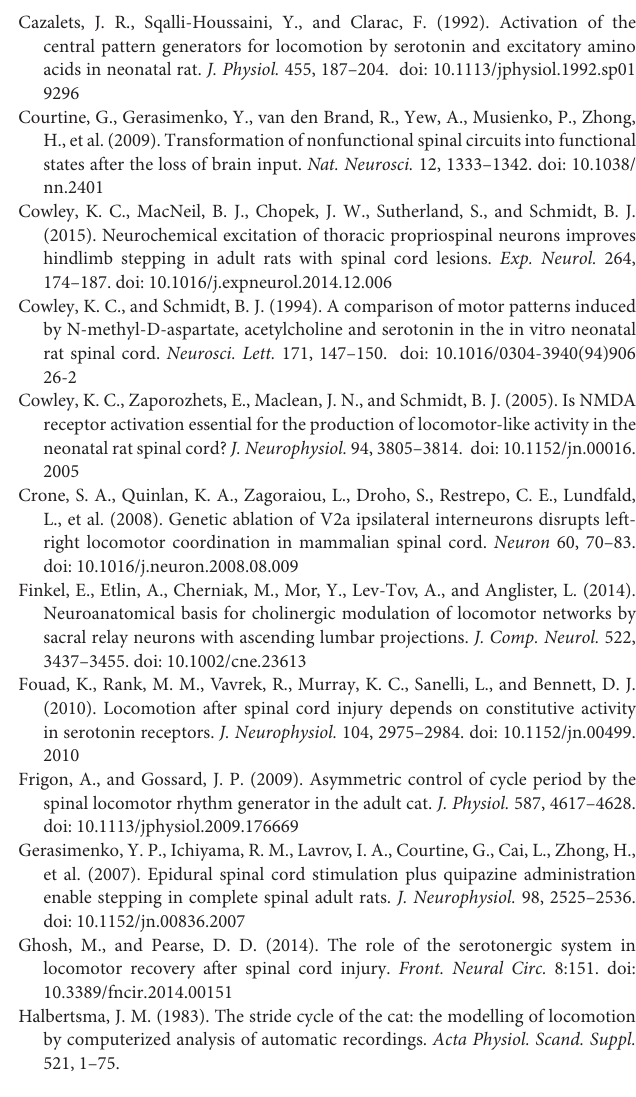
FIGURE S4 | The relationship between Add EMG burst duration vs. step cycle duration before and after Cyproheptadine (A), Volinanserin (B) and SB 242084 or SB 206553 (C) applications in the upper lumbar (UL) or low lumbar (LL) spinal cord established using regression line analysis. In the right panel (D) the bars illustrate the mean ( ± SD) of regression line slopes established for hindlimb muscles in different experimental conditions. The significance of differences in the slopes in various groups of animals before and after various treatment was tested using nonparametric Kruskal–Wallis test followed by Dunn’s test for multiple comparisons (* p < 0.05, ** p < 0.01, *** p < 0.001, **** p < 0.0001). Results from left and right muscles were pooled in all the rats in the various experimental conditions, so the number of samples taken for analysis were: Cypr UL n =